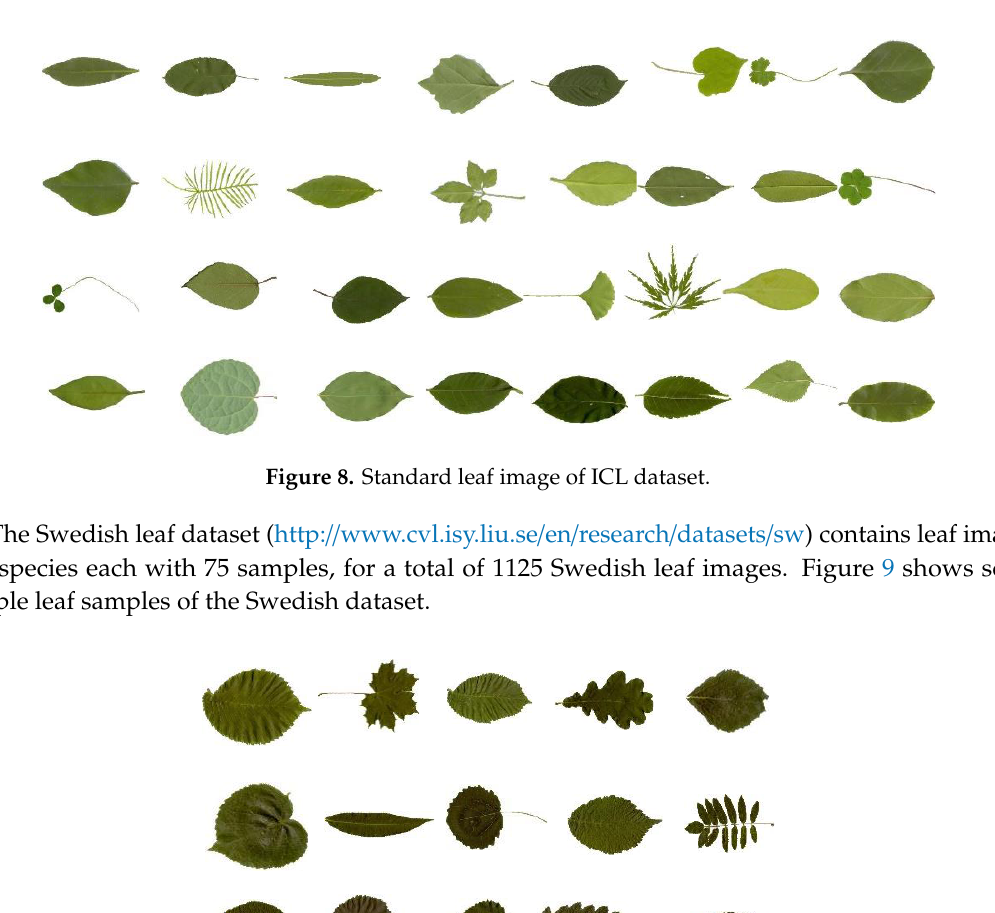
Figure 7. Standard leaf image of Flavia dataset.